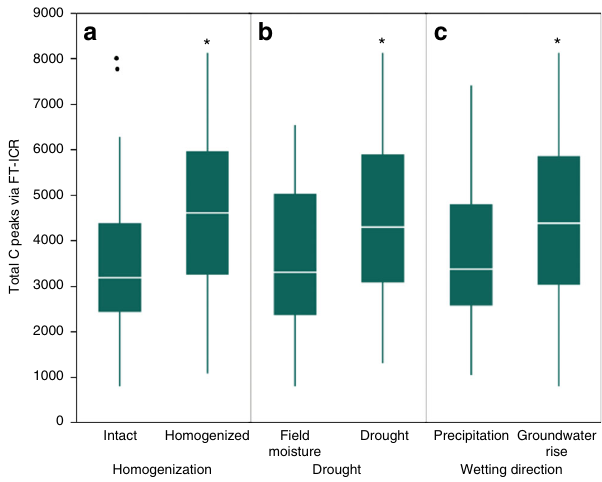
Fig. 3 Total C peaks identi fi ed in soil pore waters by soil homogenization, antecedent drought and wetting direction. The total number of Fourier- transform ion cyclotron resonance (FT-ICR) mass spectrometry peaks of organic C identi fi ed across all pore water fractions that signi fi cantly differed by a soil homogenization ( P = 0.001, n = 43 for intact, 42 for homogenized), b antecedent drought ( P = 0.011 l, n = 46 for fi eld moisture, 39 for antecedent drought), and c wetting direction ( P = 0.034, n = 44 for simulated precipitation, 41 for simulated groundwater rise). The outlier box plot whiskers represent the fi rst and third quartile minus or plus, respectively, 1.5 times the interquartile range. Soil pore water was